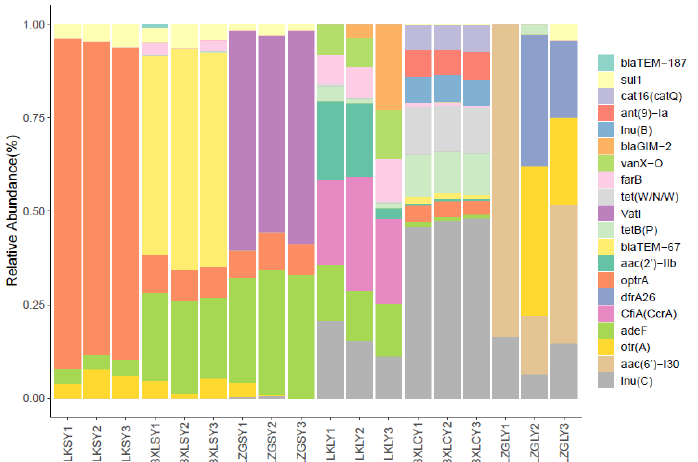
Figure 3. Relative abundances of ARGs in different samples. LK, BXL, and LZG were the abbreviation of the three fish farms. Water samples from LK farm were LKSY1, LKSY2, and LKSY3 while LKLY1, LKLY2, and LKLY3 were the name of fish gut content samples from LK fish farm. Likewise, BXLSY1-3 and LZGSY1-3 were water samples from BXL and LZG fish farm, respectively. BXLCY1-3 and LZGLY 1-3 were fish gut contents from BXL and LZG fish farm, respectively.